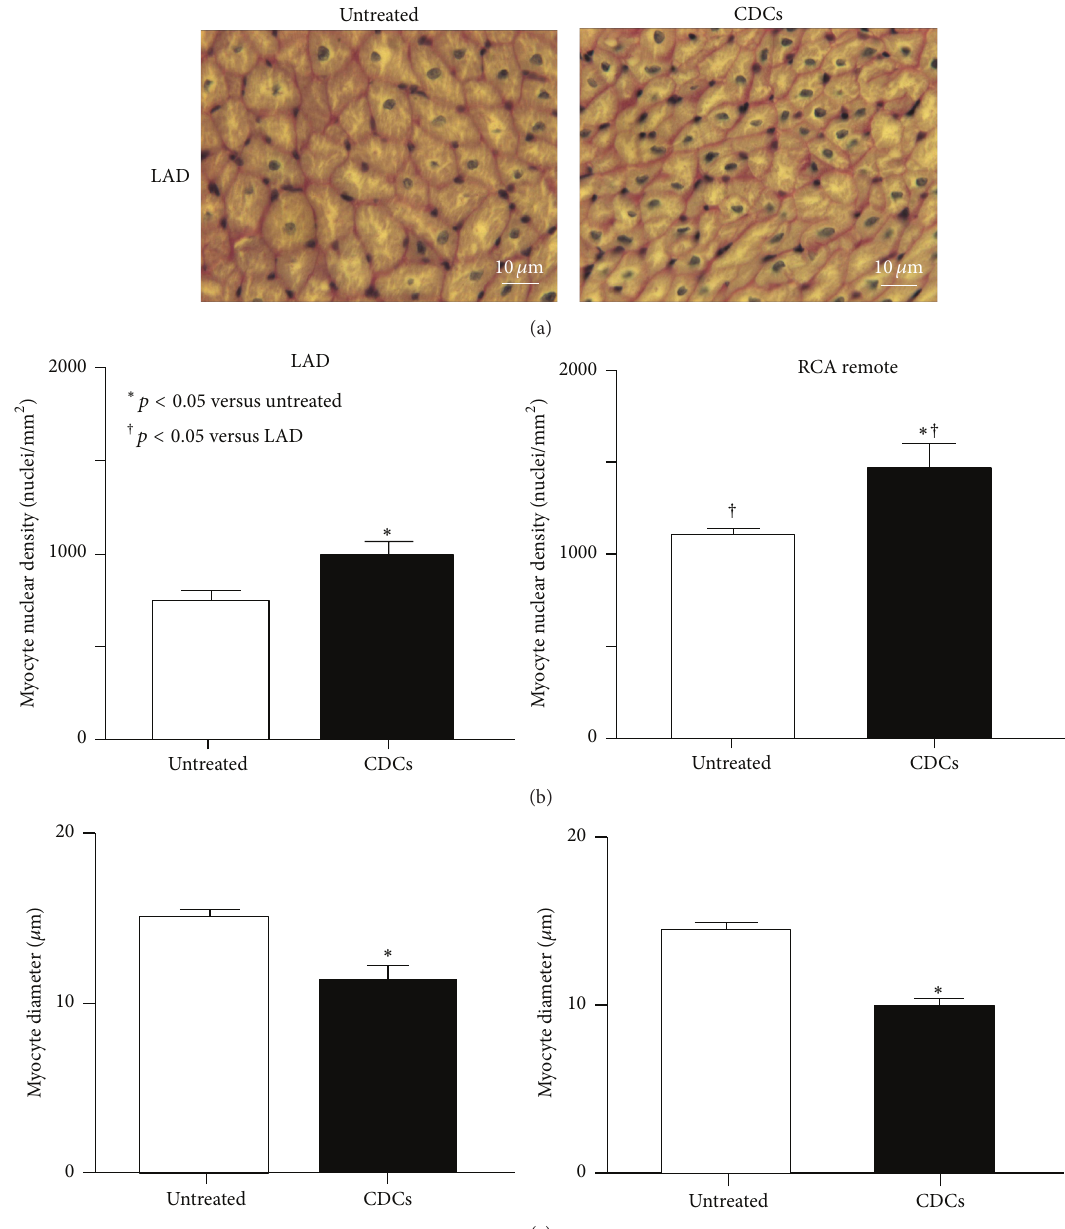
Figure 7: The effects of CDCs on myocyte number and myocyte size. (a) Upper images represent PAS stained cardiac myocytes in LAD region fromuntreatedandCDCtreatedanimals.(b)Myocytenucleardensitywasquantifiedasacumulativeindexofmyocyteregenerationfollowing CDC infusion. In untreated animals, myocyte nuclear density was significantly reduced, reflecting infarct-related myocyte loss. After CDCs there was a significant increase in myocyte nuclear density in LAD and RCA remote regions. (c) The myocyte regeneration that resulted from CDCs led to a global reduction in myocyte diameter as compared to untreated controls. There was a significant reduction in myocyte size in both LAD and RCA remote regions. This supports the formation of new myocytes as a cause of the global functional